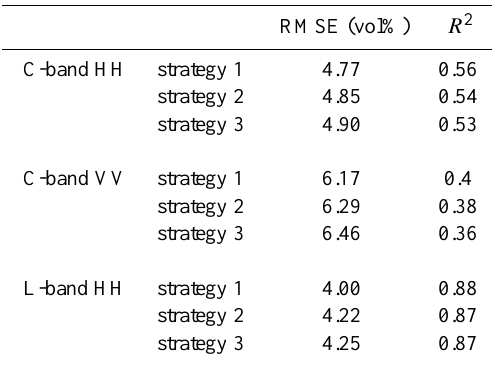
Table 3. Cross-validation of the soil moisture retrieval technique